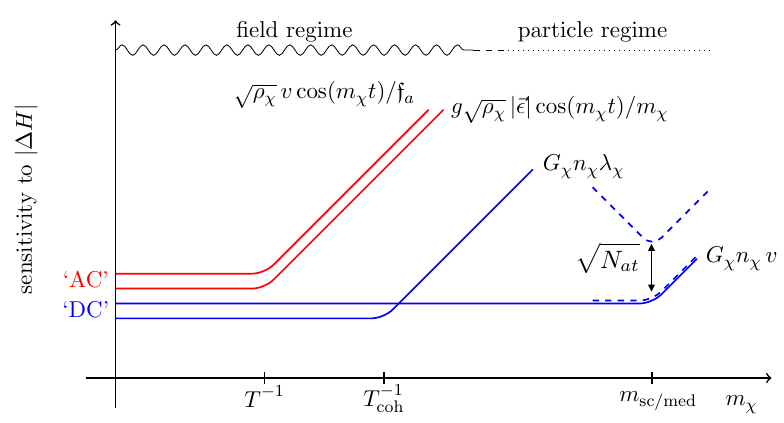
Figure 9 : Qualitative depiction of the sensitivity to the contribution to the energy dif- ference (frequency) in the di ↵ erent regimes and types of DM coupling. Solid (dashed) lines correspond to bosonic (fermionic) DM candidates, the scaling is merely symbolic and meant to represent a loss of sensitivity at the di ↵ erent thresholds T i , see sec. 5 for plots.